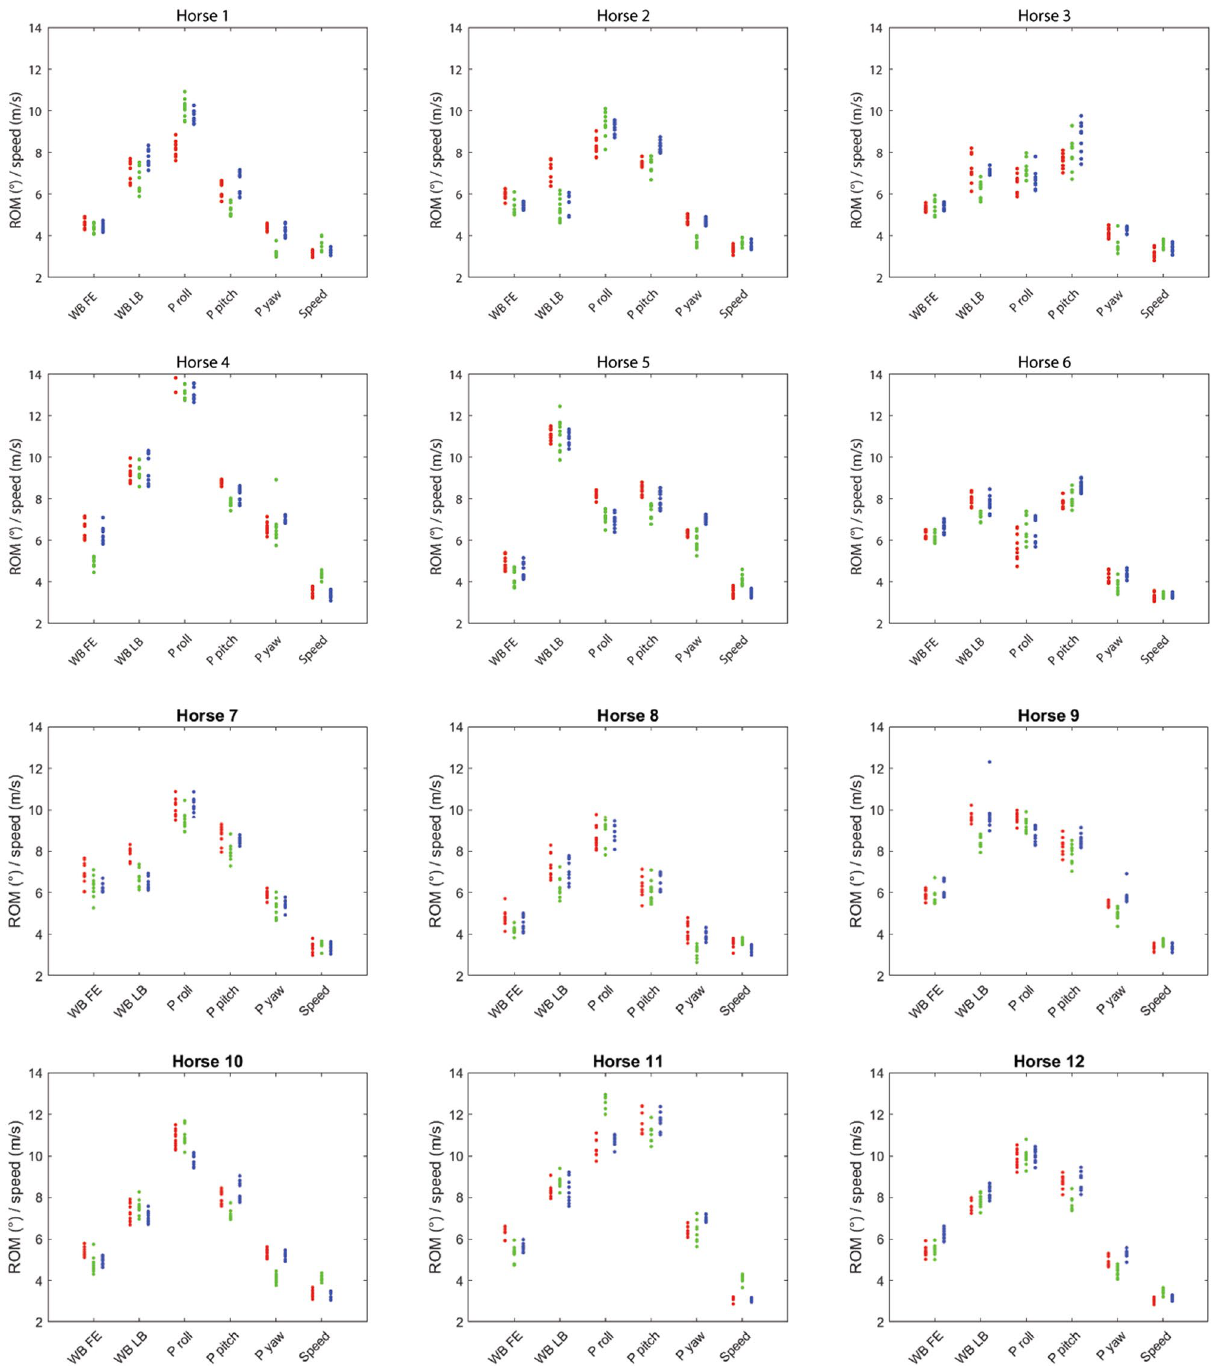
Figure 5. Measurement mean data plotted by horse for selected stride range of motion (ROM) variables for whole back (WB) flexion–extension (FE) and lateral bending (LB), pelvis (P) roll, pitch and yaw, and speed. The plots contain data from 12 horses on three paths (red = left, blue = right, green = straight line), studied during two different days for five occasions each day (n = 355 measurements in pelvis yaw, the estimated differences compared to straight were also small (left 2.46°; right − 2.22° vs. straight). In equestrian literature, lateral bending of the trunk is often referred to and is a core part of the training goals, even though there are some equestrian authors that dispute the horse’s ability to bend laterally other than in the cervical spine 31 . It is unclear whether these observations that are reported in equestrian literature, are based on actual lateral bending of the back, or reflect the concurrent changes in limb movement 1 and muscle activity 32 when moving in circles, e.g. shorter stride length for inside limbs compared to outside limbs. The slight increase in extension of the back and differences in back and pelvic ROM are unlikely to be appreciable with an unaided